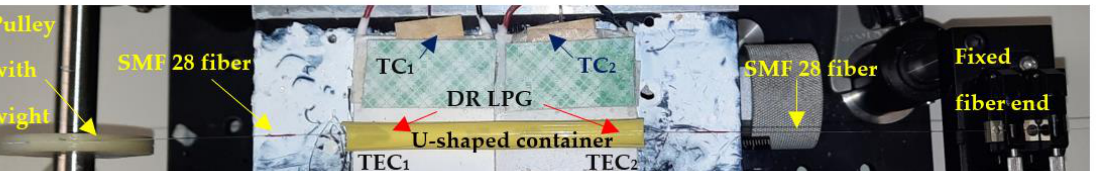
Figure 5. Experimental jig: the DR LPG spliced between two SMF 28 fibers was placed in a U-shaped container (yellow), which was placed on two thermoelectric coolers, TEC 1 and TEC 2 , mounted on a heat sink covered with thermoconductive paste (white) and upon which were fixed two thermocou- ples, TC 1 and TC 2 .